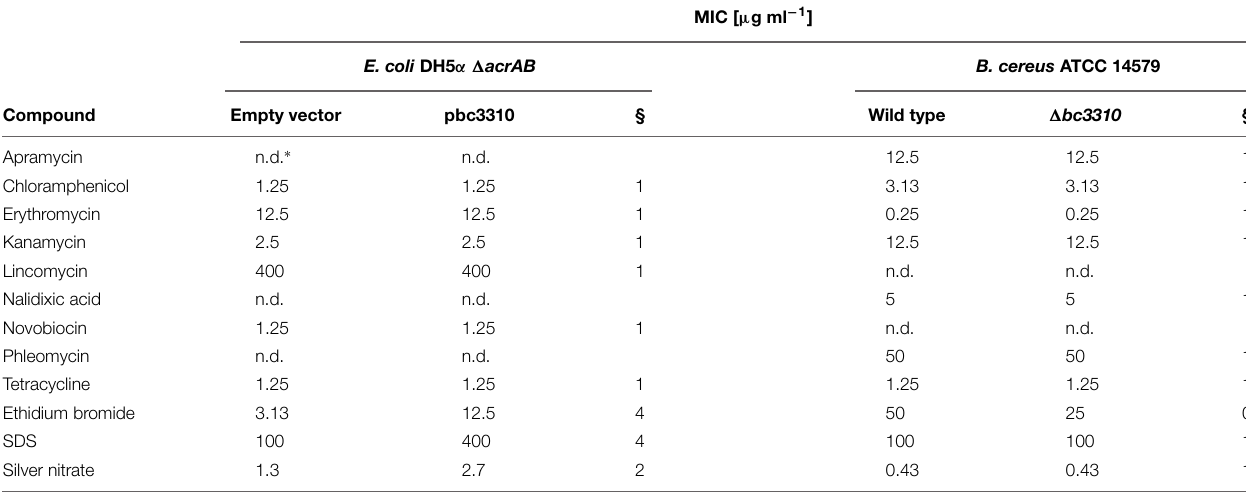
TABLE 2 | Minimal inhibition concentration (MIC) of E. coli DH5 α (cid:2) acrAB expressing BC3310 (pbc3310) compared to empty vector control (pTTQ18) and Bacillus cereus ATCC 14579 (cid:2) bc3310 ( (cid:2) bc3310) compared to B. cereus ATCC 14579 (wild